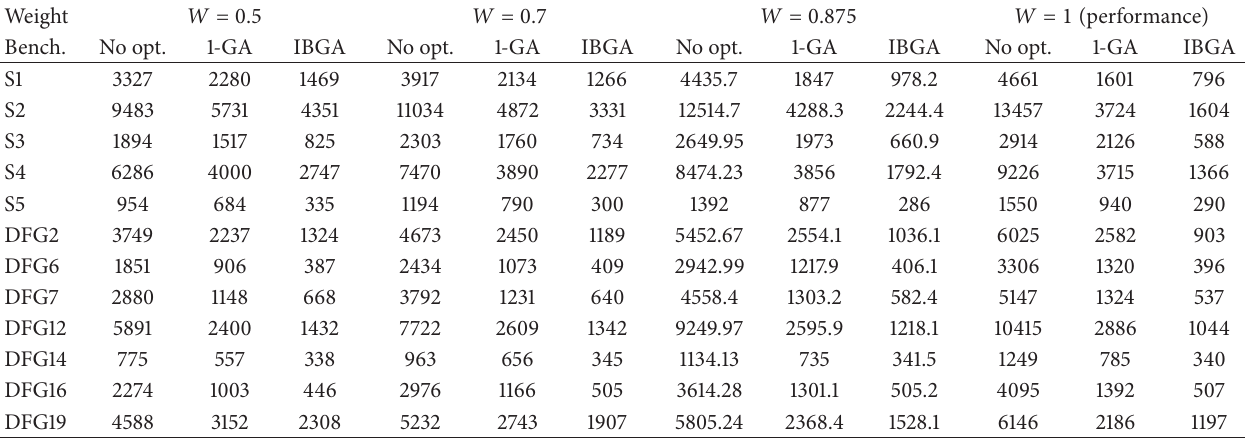
Table 13: Fitness values for different weights ( 𝑊 ).